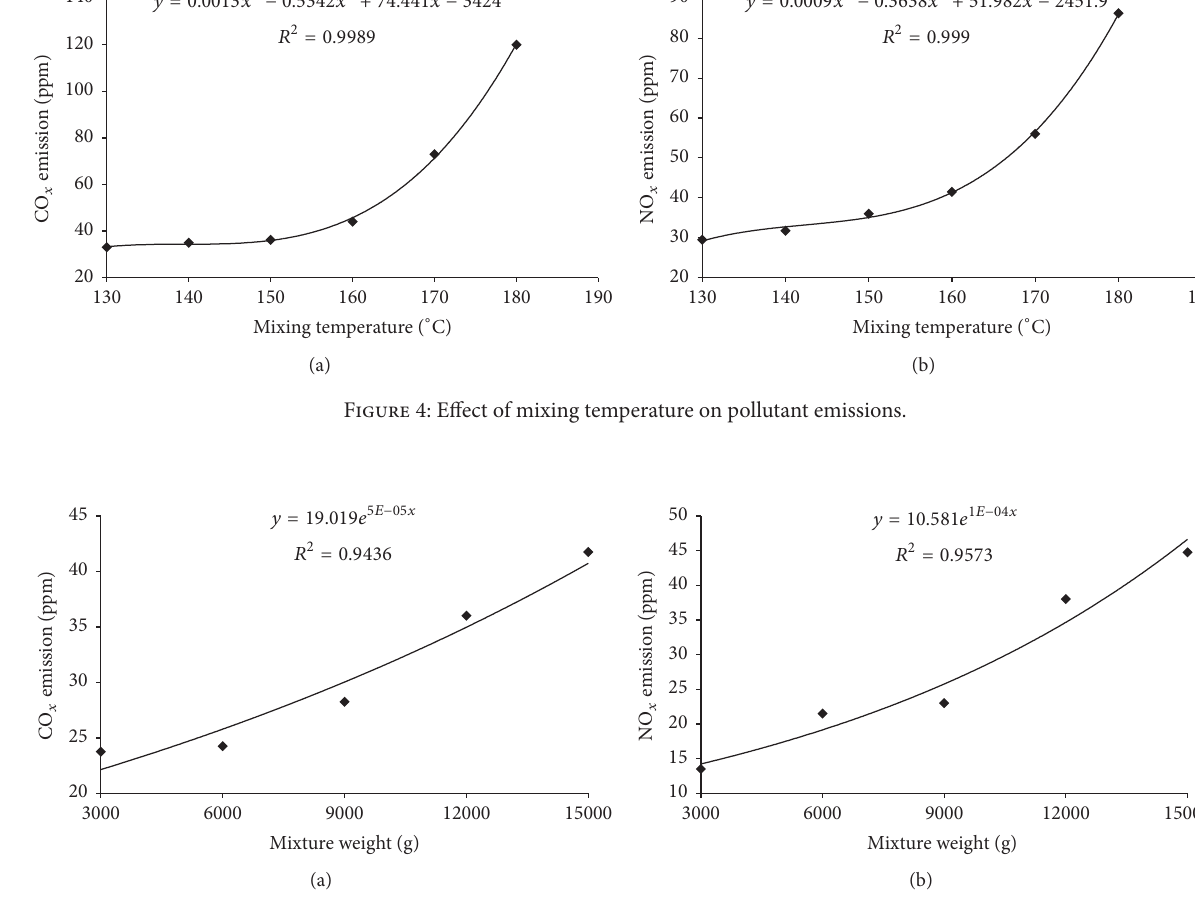
Figure 5: Effect of mixture weight on pollutant